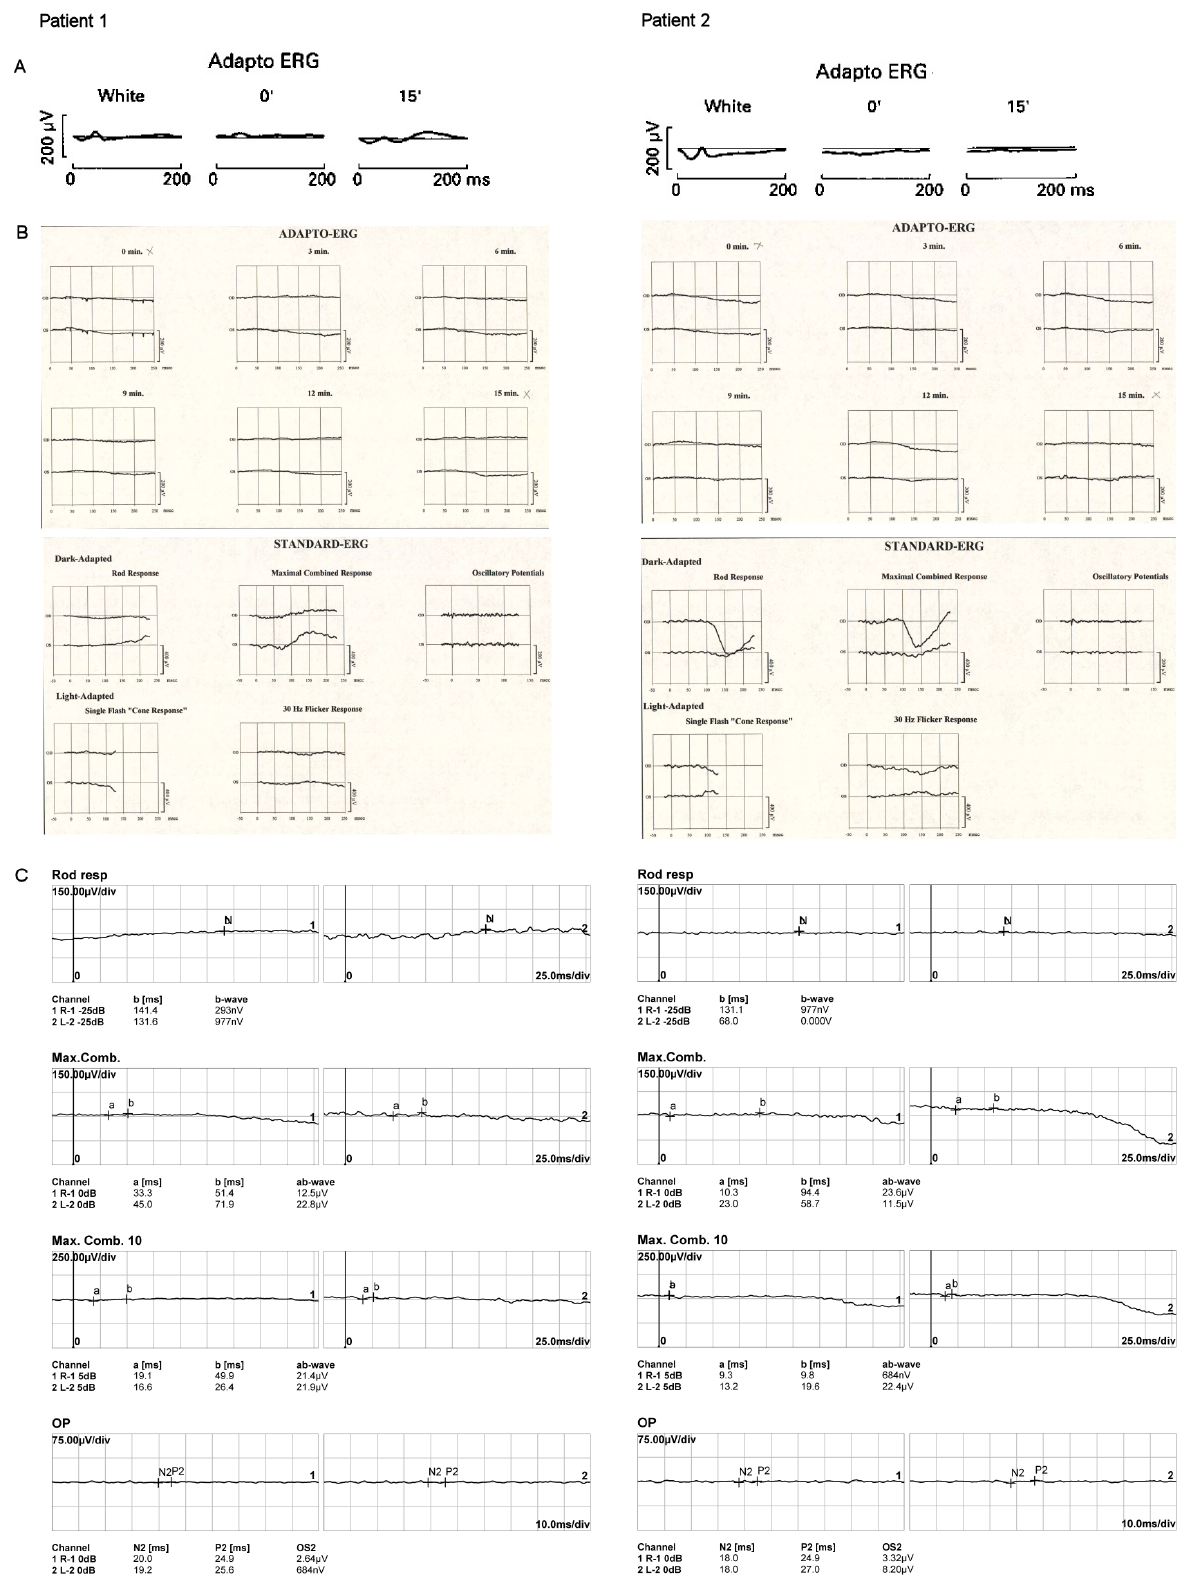
Figure 1: Electroretinographic findings in twin sisters (patient 1 and patient 2) with PMM2-CDG at the age of 4 years (A), 18 years (B) and 41 years